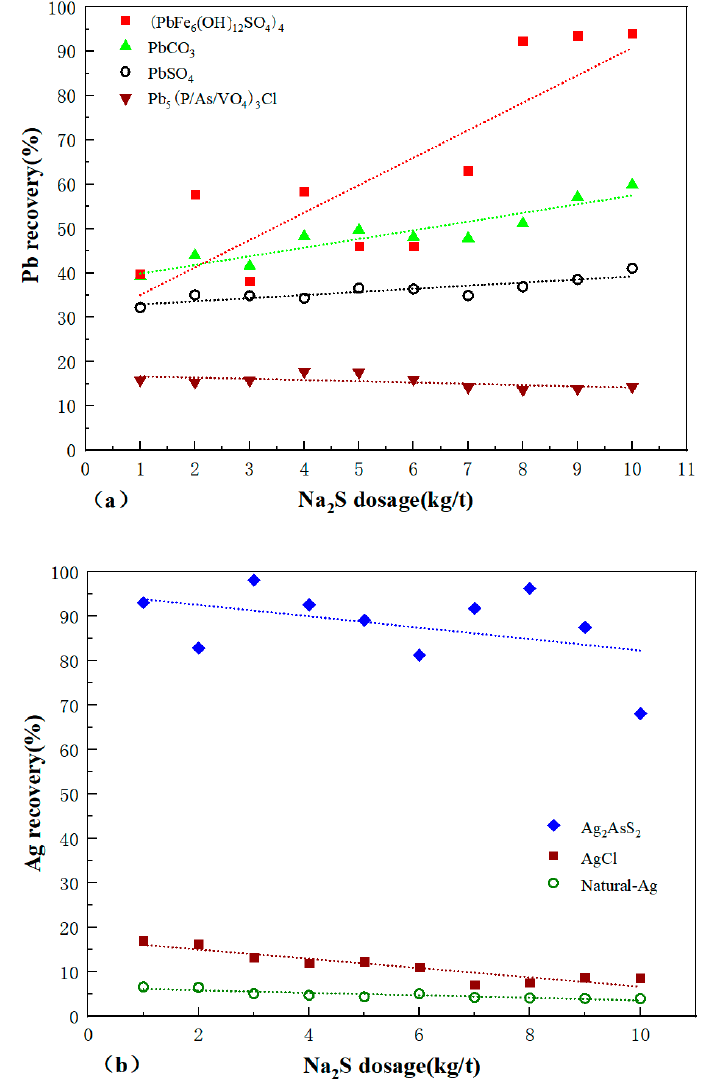
Figure 2. Flotation recovery at different dosages of Na 2 S. ( a ) Pb recovery of (PbFe 6 (OH) 12 SO 4 ) 4, PbCO 3 , PbSO 4 , and Pb 5 (P/As/VO 4 ) 3 Cl; ( b ) Ag recovery of Ag 2 AsS 2 , AgCl, and natural ‐ Ag.